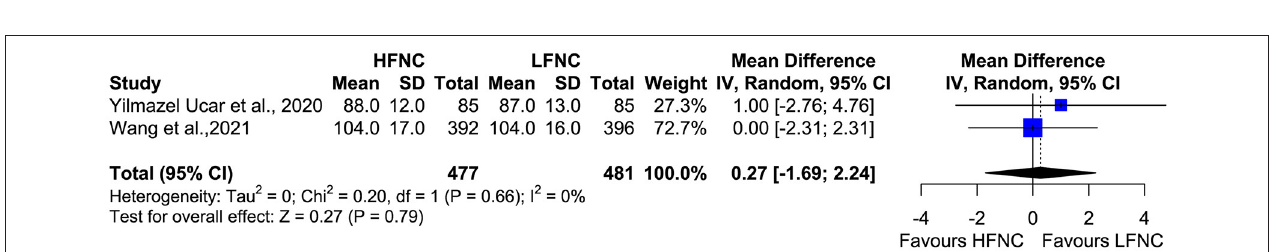
FIGURE 11 | Meta-analysis of HR 10 minutes after the end of the procedure in patients receiving HFNC compared to LFNC in patients undergoing bronchoscopic procedures.